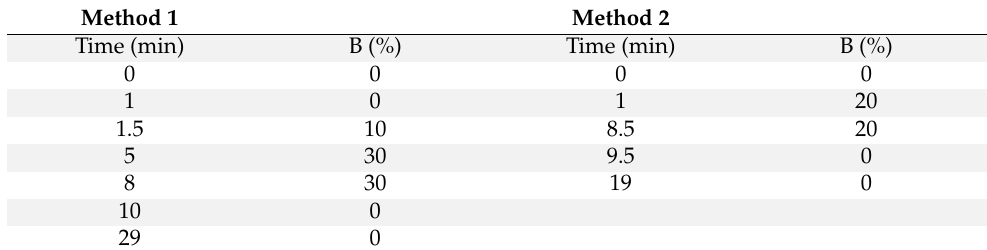
Table 2. Solvent gradients for the different HPLC